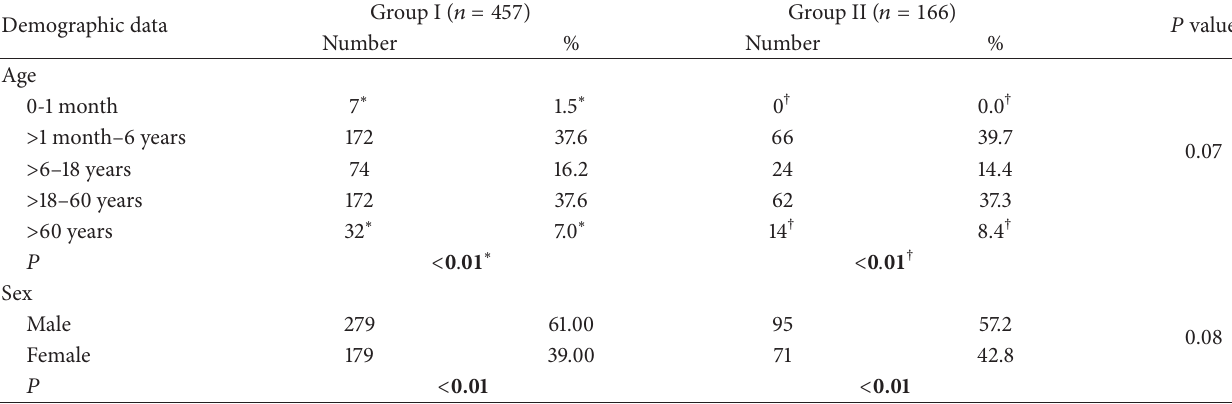
Table 1: Demographic data of bacterial and nonbacterial meningitis in the studied